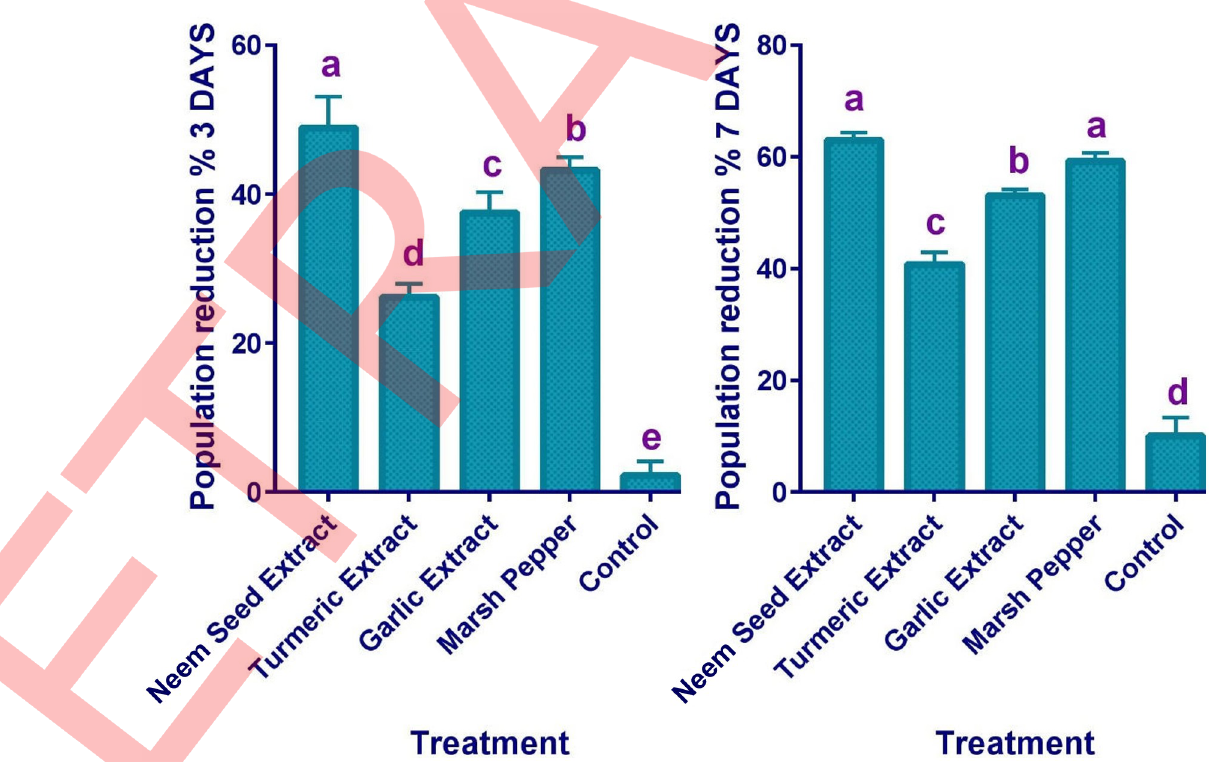
Fig 2. Population reduction percentage of H . armigera larvae in first round of spray at 3 and 7 days after treatment (DAT) on tomato plants treated with foliar application of various plant extracts. The values are means ± SD (n = 3). Different lower-case letters on bars indicate significant differences among treatments at P <